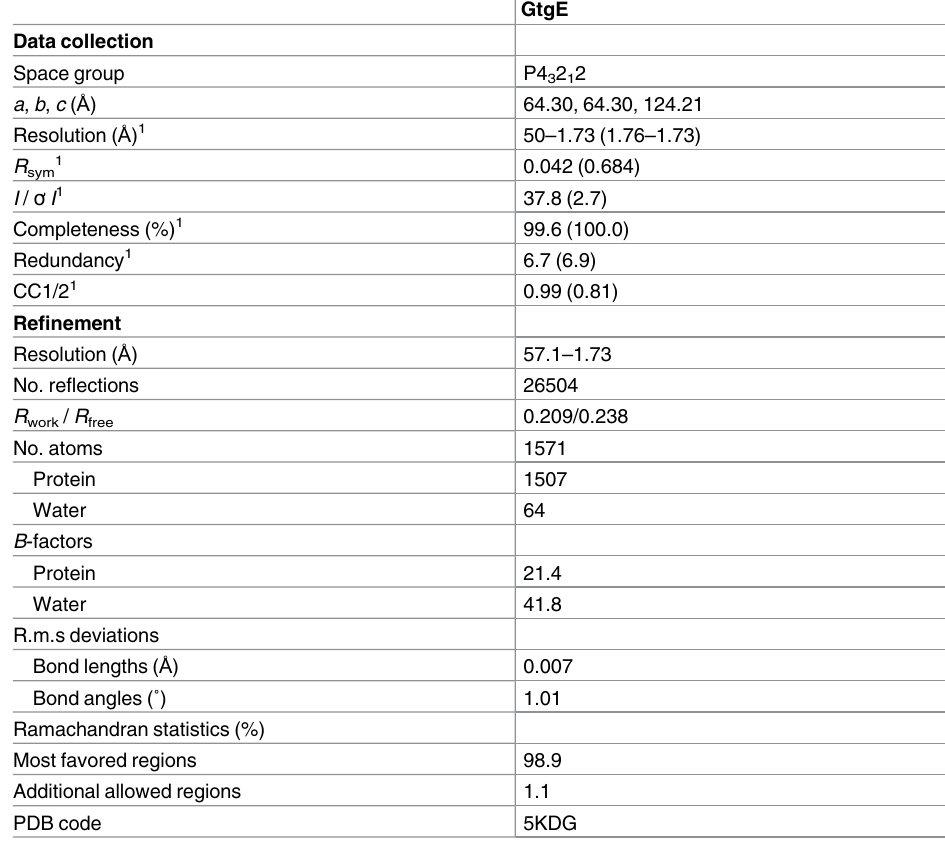
Table 1. Statistics of data collection and